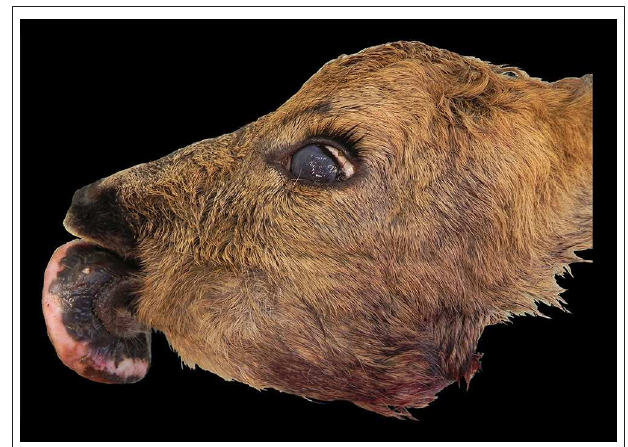
FIGURE 1 | Head, roe deer ( Capreolus capreolus ); a mass is expanding from the rostral aspect of the mandible.